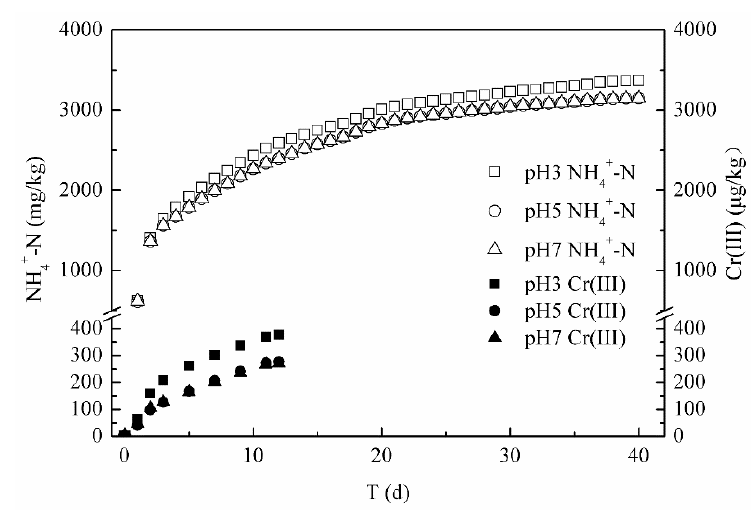
Figure 5. Accumulation releasing amounts of Cr(III) and NH 4 + -N from tannery sludge.